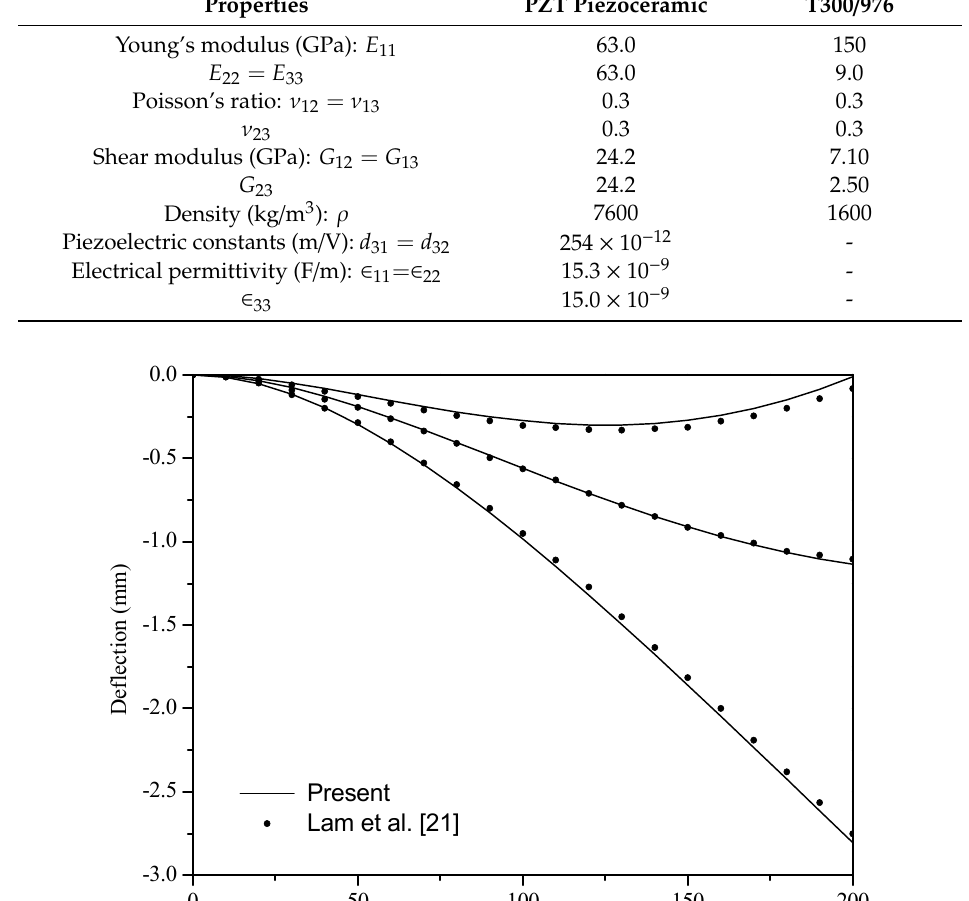
Table 1. Material properties [21].